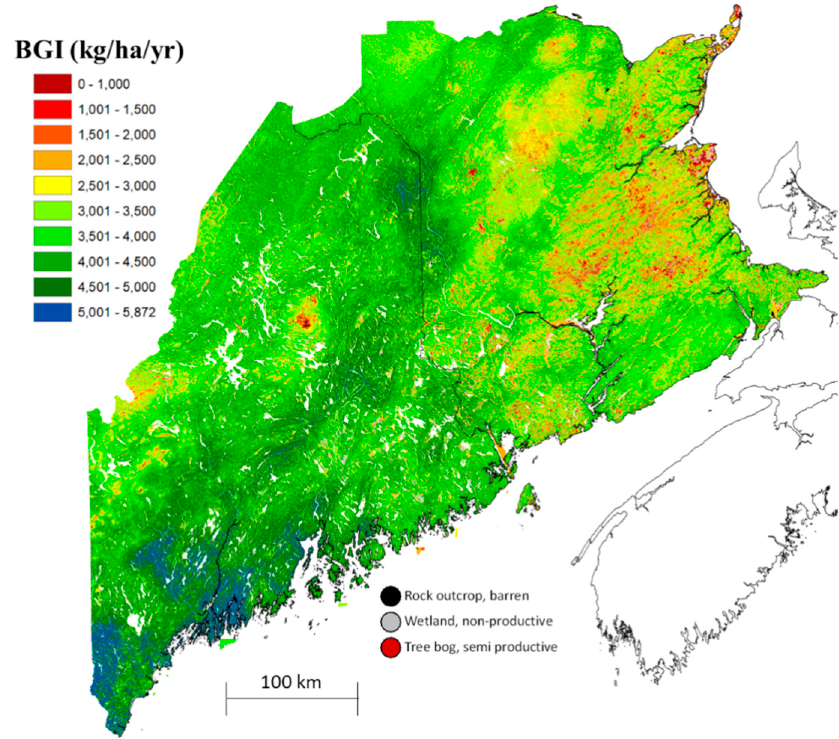
Figure 3. Base biomass growth index (BGI; kg ha − 1 year − 1 ) map estimated at 20 m resolution over the study area.